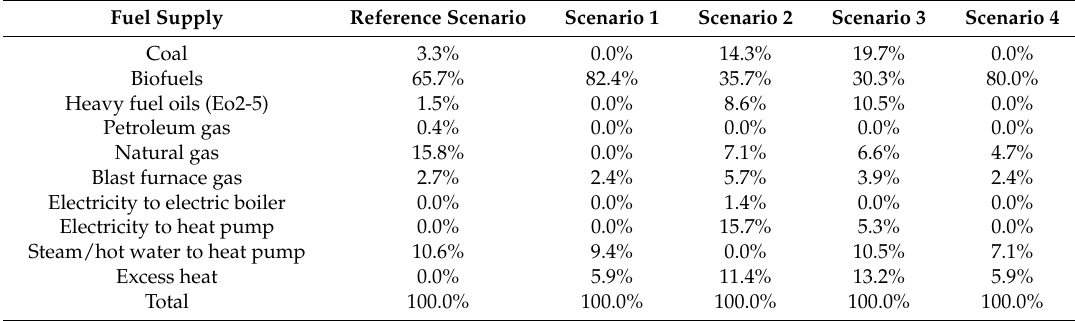
Table A5. Average heat mixes for the reference scenario and four base scenarios for the year 2030.